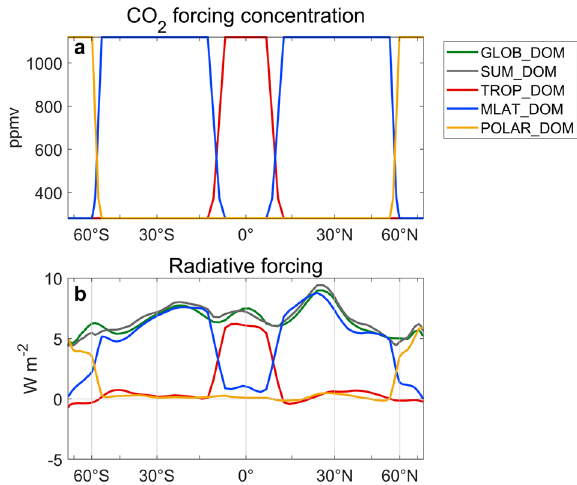
Fig. 2 CO 2 forcing structures and radiative forcings. a The annual- and zonal-mean pro fi le of CO 2 concentration and b radiative forcing in GLOB_DOM (green), TROP_DOM (red), MLAT_DOM (blue), POLAR_DOM (yellow), and the sum of all regional forcing experi- ments SUM_DOM